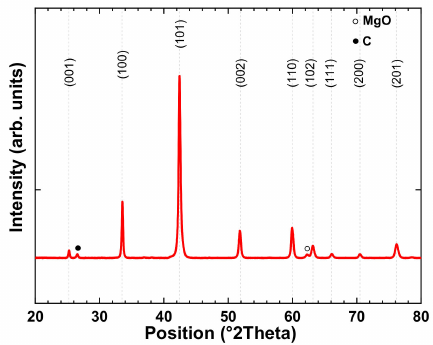
Figure 1. X-ray diagram of sample A.